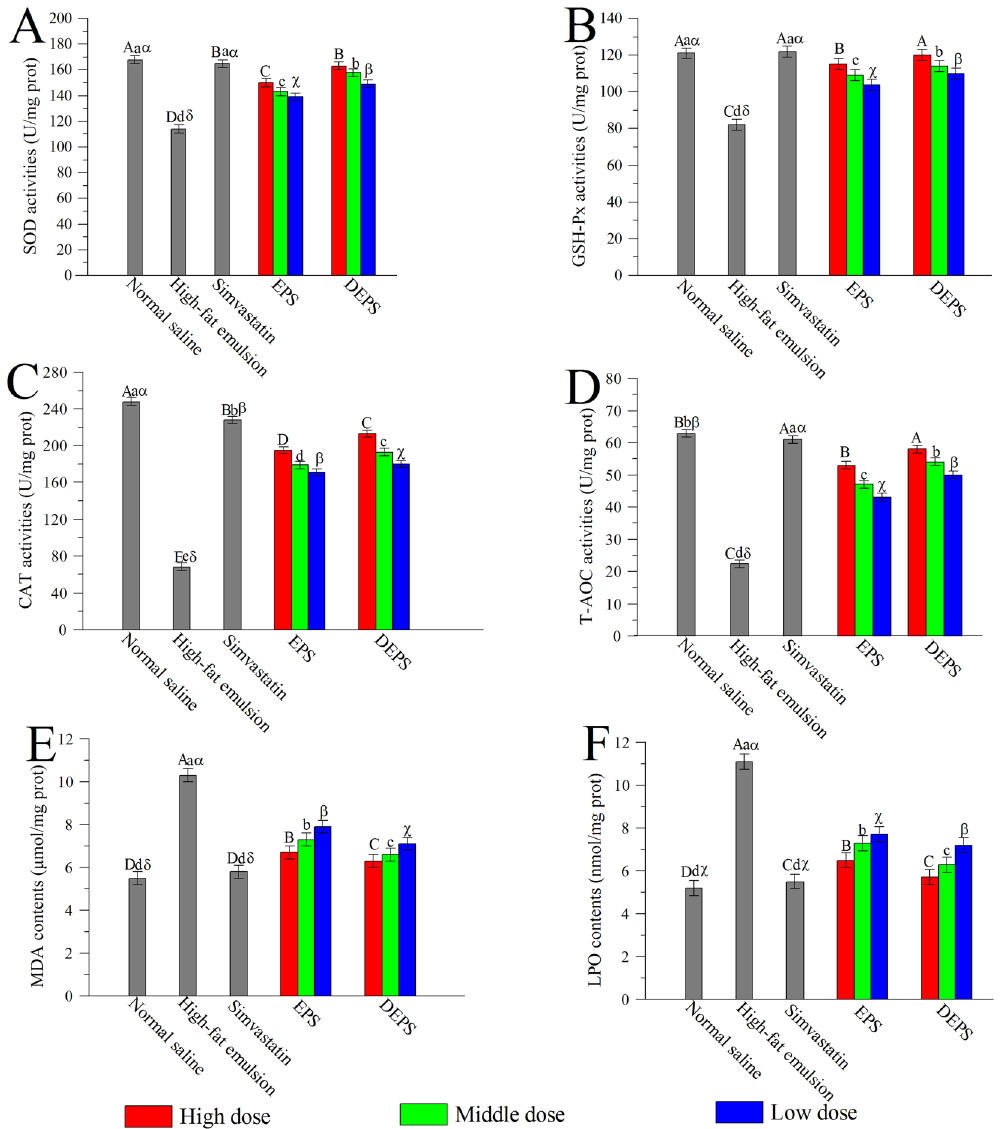
Figure 5. Effects of EPS and DEPS on SOD ( A ), GSH-Px ( B ), CAT ( C ), and T-AOC ( D ) activities and the MDA ( E ) and LPO ( F ) contents. The values are reported as means ± SD (n = 10). Bars with different letters are significantly different ( P <